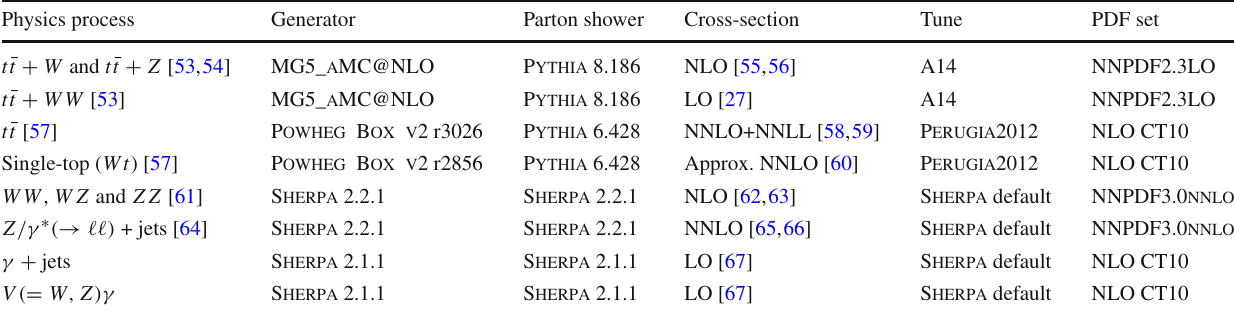
Table 2 Simulated background event samples used in this analysis with the corresponding matrix element and parton shower generators, cross- section order in α S used to normalise the event yield, underlying-event tune and PDF